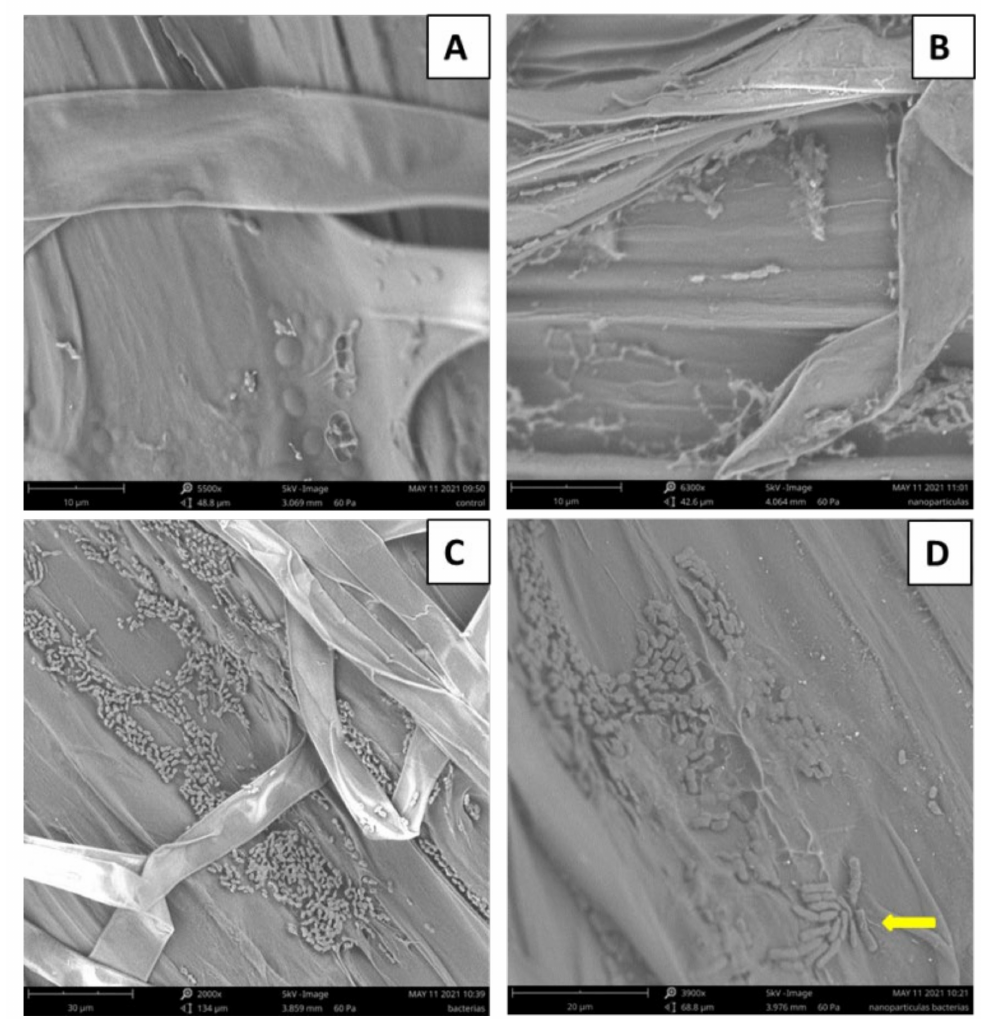
Figure 2. Observation by low-vacuum SEM microscopy of wheat roots subjected to different inocula- tion treatments. ( A ): Non-inoculated control plants. ( B ): Non-inoculated plants in the presence of FeNPs (few bacteria are sporadically observed in A, B, probably reflecting the presence of endophytes or residual contamination). ( C ): Plants inoculated with Bacillus aryabhattai RSO25 in the absence of FeNPs. ( D ): Plants inoculated with Bacillus aryabhattai RSO25 in the presence of 1% FeNPs. Yellow arrow points a cell in division, indicating that the concentration of FeNPs was not inhibitory to bacterial